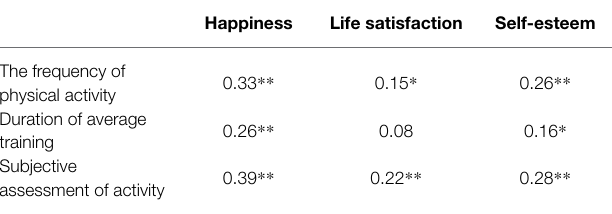
TABLE 4 | Correlations between the happiness, life satisfaction, self-esteem, and physical activity variables.